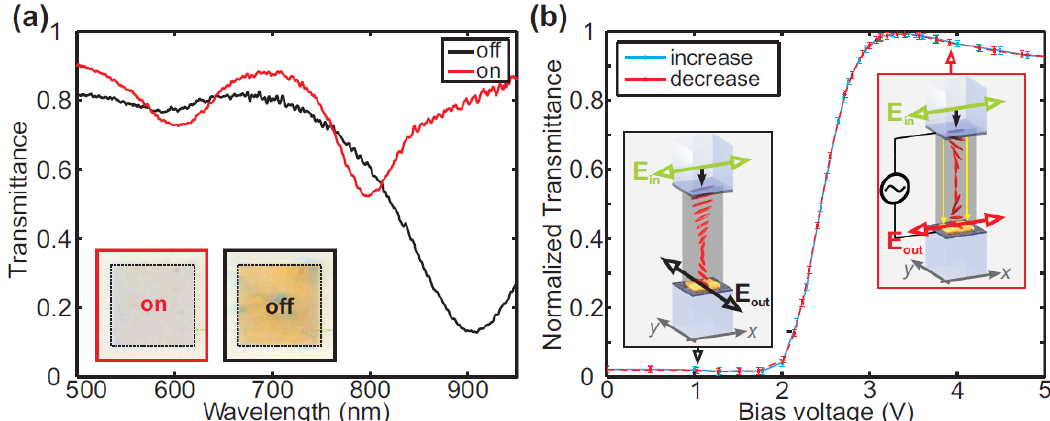
Figure 2. ( a ) Measured transmission of LC-covered metasurfaces when the external electric field is on and off. The insets demonstrate captured charge-coupled device (CCD) images showing the color difference from yellow to almost transparent. ( b ) Normalized transmittance as a function of bias voltage. The threshold behavior can be clearly observed for the switching process. Insets show schematic of LC-cells alignment without (left) and with (right) electric field. Reproduced with permission from [99]. Copyright Optical Society of America, 2013.